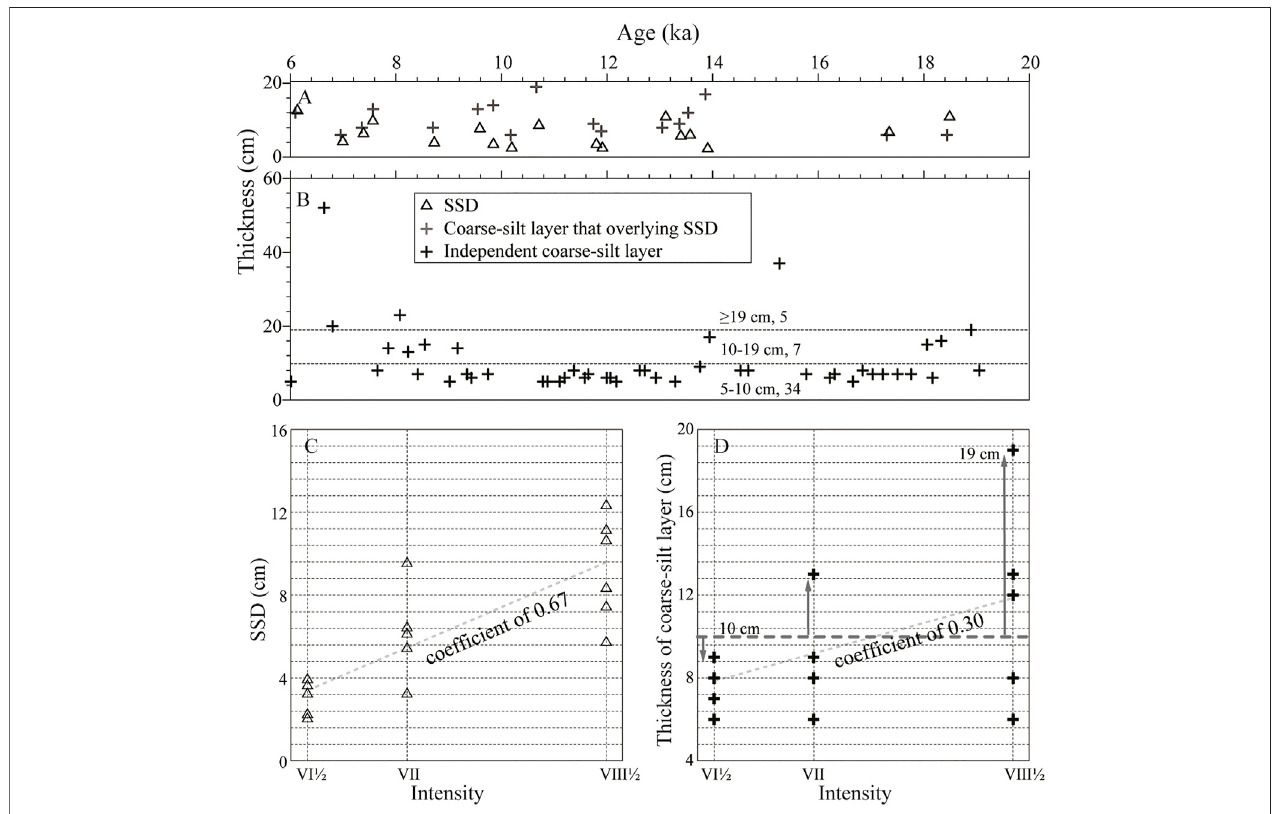
FIGURE 4 | Thickness variations and analysis of the SSD structures and coarse-silt layers with time (A) Distribution characteristics of the SSD structures and overlyingcoarse-siltlayers,and (B) theindependentcoarse-siltlayers (C) CorrelationofSSDstructureand (D) itsoverlyingcoarse-siltlayerswithMMI,notethattheSSD thickness has better correlation with seismic intensity that than its overlying coarse-silt